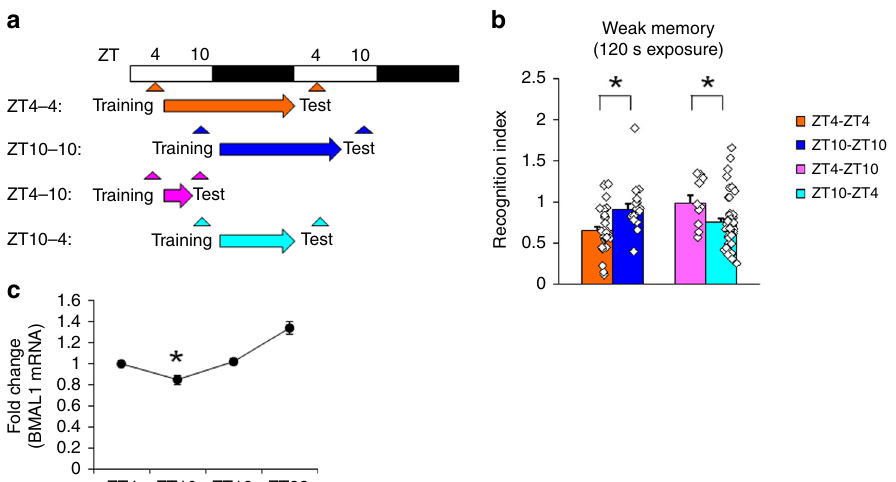
Fig. 1 Retrieval of social recognition memory is impaired at ZT10 following weak training in wild-type (WT) mice. a Experimental design. b Memory retrieval (recognition index) is impaired (higher recognition index) following weak social recognition training (2 min exposure to novel mouse during training) at ZT10, independent of the time of training. c BMAL1 mRNA levels in the whole hippocampus are reduced at ZT10 compared to other time points (quantitative RT-PCR). The graph represents fold changes compared to expression levels at ZT4. * p < 0.05, compared to the other time points. All values are mean ± SEM. Individual data points are displayed as dots. * p < 0.05 as determined by two-way ( b ) or one-way ( c ) ANOVA with post hoc test. The results of the statistical analyses are presented in Supplementary Table 2. Source data are provided as a source data fi